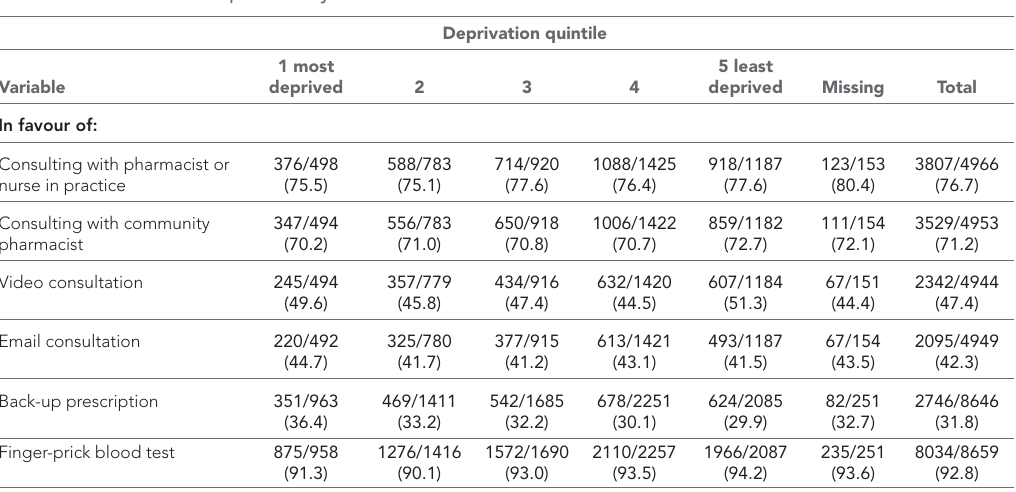
Table 2 Variation in responses by socioeconomic